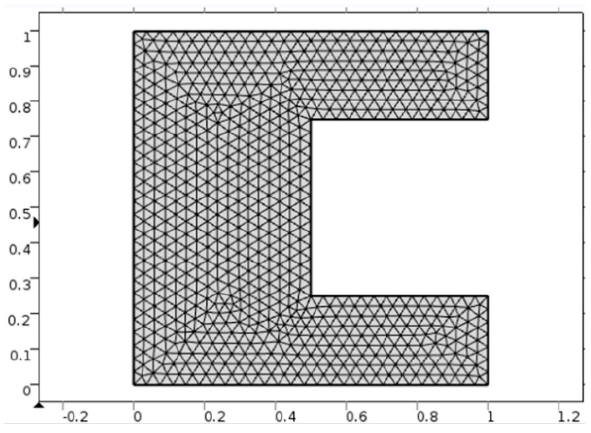
Table 5. The results of examining the independence of the network in terms of φ = 0.04, Ha = 40, and α = 0.